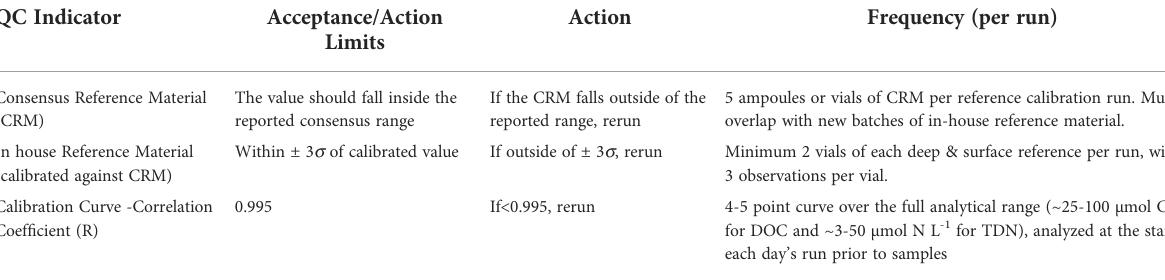
TABLE 3 Suggested quality control criteria and guidelines. QC Indicator Acceptance/Action Limits